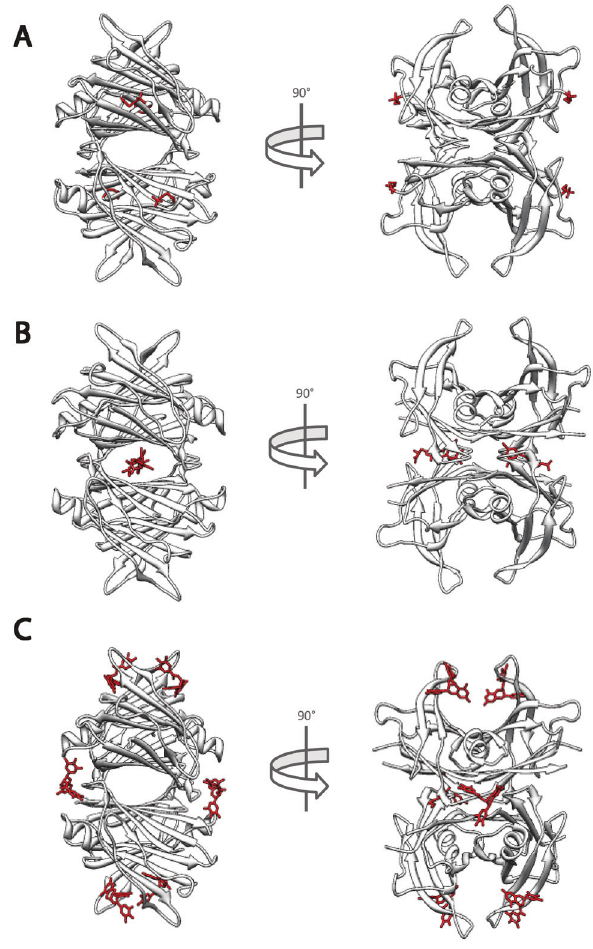
Figure 1 Examples of interaction sites that can be targeted to prevent TTR